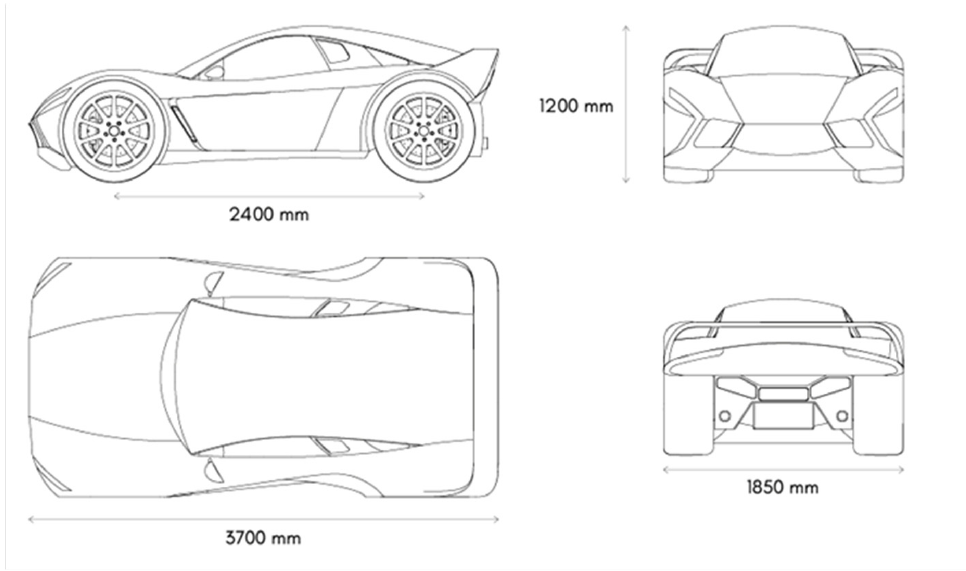
Figure 28. Stone concept 2D Drawings.